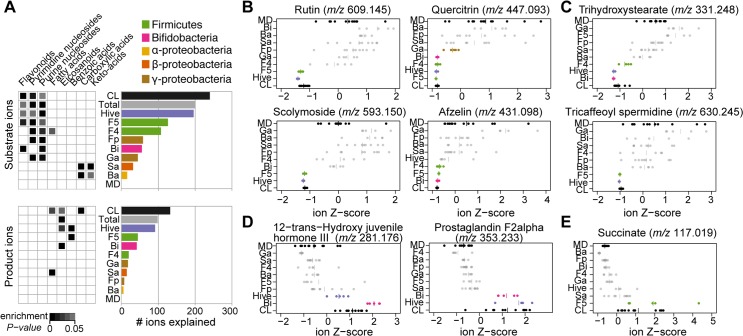
Overview of metabolite changes explained by different community members of the bee gut microbiota.(A) Bar graphs show the fraction of the metabolic changes explained by mono-colonizations and hive bees for substrates (240 ions) and products (132 ions). The category “Total” indicates the total number of ions explained by mono-colonizations, thus excluding hive bees. Heatmap representation of enrichment P values (one-sided Fisher’s exact test P < 0.05) are provided for compound categories enriched in one or several mono-colonizations. (B–E) Z-score transformed ion intensities of selected substrate and product ions are shown for all treatment groups. (B) Four glycosylated flavonoid substrates. (C) Two substrates from the outer pollen wall. (D) Two products corresponding to host-derived metabolites. (E) Succinate, one of the major fermentation products. Groups depicted in color highlight treatment groups displaying a significant difference compared to MD bees in the same direction as the CL versus MD difference (one-way analysis of variance [ANOVA], Tukey honest significant difference [HSD] post hoc test at 99% confidence, P ≤ 0.05). Plots for all 372 ions are provided in S8 Data. Ba, B. apis mono-colonized; Bi, B. asteroides mono-colonized; CL, colonized with the reconstituted microbiota; F4, Firm-4 mono-colonized; F5, Firm-5 mono-colonized; Fp, F. perrara mono-colonized; Ga, G. apicola mono-colonized; Hive, hive bees; MD, microbiota-depleted; Sa, S. alvi mono-colonized. The numerical results of the full enrichment analysis, bar graphs, and mono-colonization plots are provided in S3 Data, S1 Data and S8 Data, respectively.